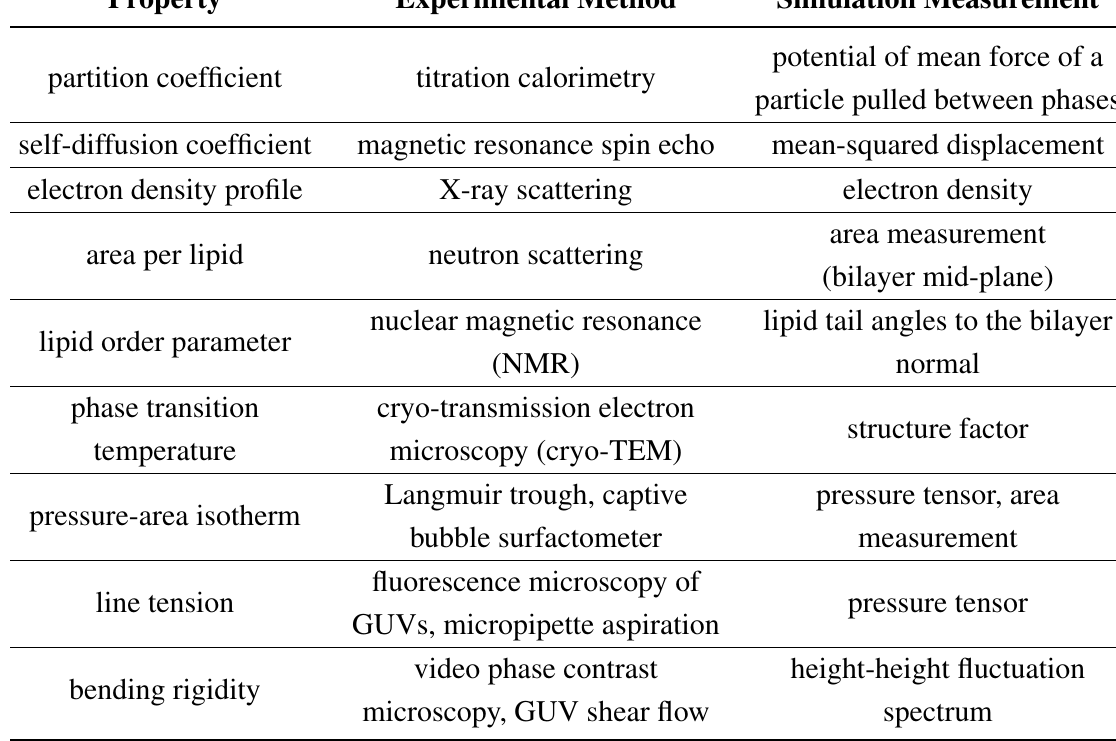
Table 2. Summary of corresponding experimental methods and simulation measurements which may be used match key physical properties of soft matter